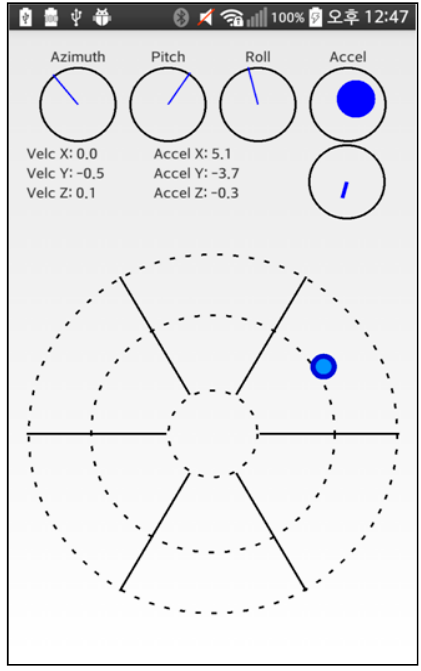
Figure 19. An Android Application that Measures Distance to a Beacon (Scenario 2).